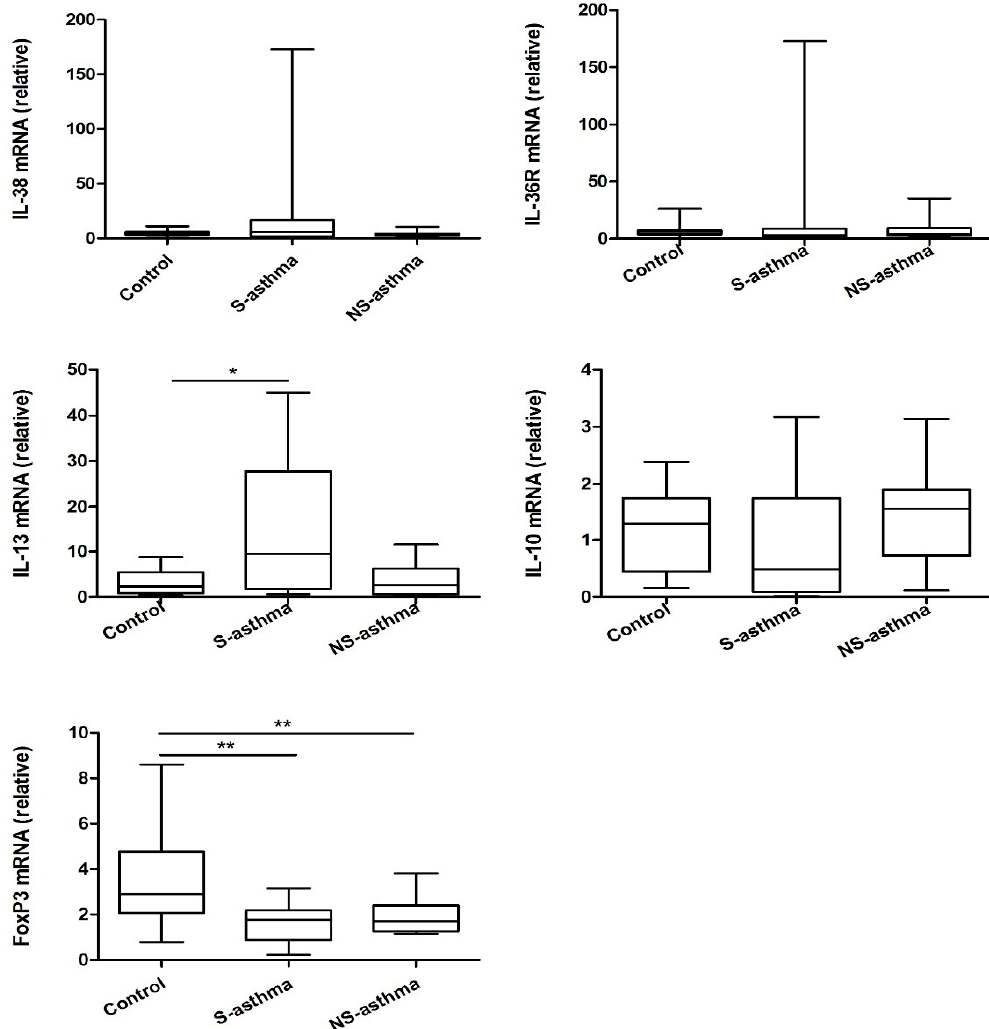
Figure 3. The differences of mRNA expression of IL-38, IL-36R, IL-13, IL-10 and FoxP3 between asthmatic patients and controls. PBMC was purified and total RNA was extracted, reverse transcribed and analyzed by real time PCR. Results are presented as box and whisker plots with median (interquartile range). Statistical significances were indicated by * p < 0.05 and ** p < 0.01 (Mann-Whitney U test). S-asthma: steroid-treated asthmatic patients; NS-asthma: non-steroid-treated asthmatic patients,